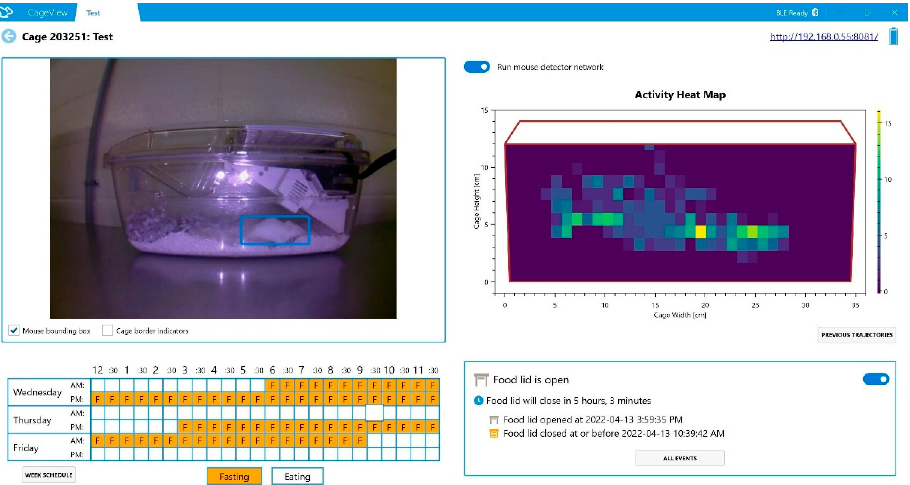
Figure 3. Sample screenshot of the interface software of the desktop application showing the live stream of the cage, feeding and fasting schedule, mouse trajectory, history of the animal’s access to food, and the experimenter’s options to open or close the food access door.